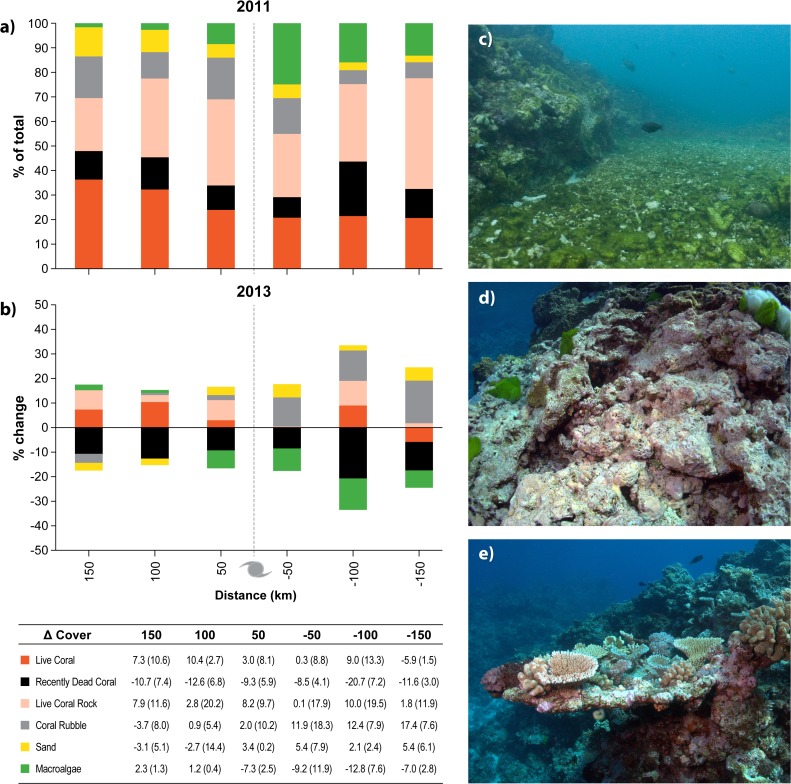
Changes in benthic cover between 2011 and 2013 based on recovery surveys from a sub-set of reefs surveyed 150 km north to 100 km south of the cyclone track (Fig. 2 for reef locations).(a) Proportion of the benthos made up by live coral, recently dead coral, live coral rock, coral rubble, sand and macroalgae. (b) Positive (increasing) and negative (decreasing) percent changes between 2011 and 2013 are shown for each benthic cover category. Average values for change presented in (b) are shown in the table for each segment and benthic cover category with standard deviation values in brackets. Photographs on the right show (c) algae blooms following TC Yasi in 2011, (d) the transition from recently dead coral to live coral rock, and (e) coral recruitment and recovery at Helix Reef.